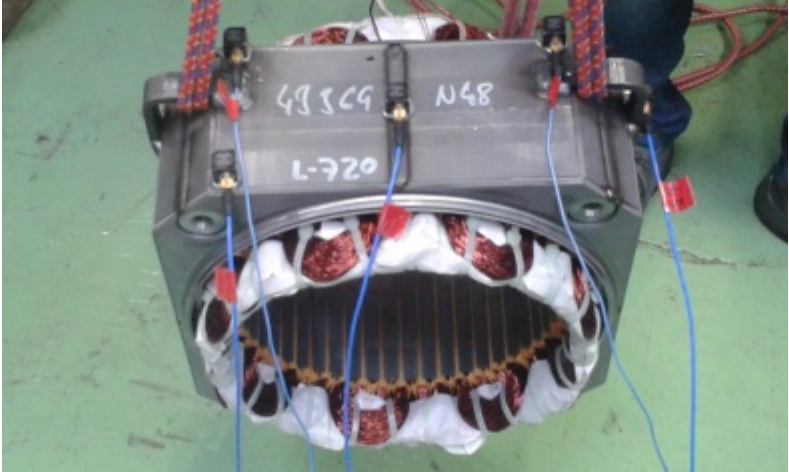
Figure 2. Experimental setup of the measurement of the natural frequencies of the